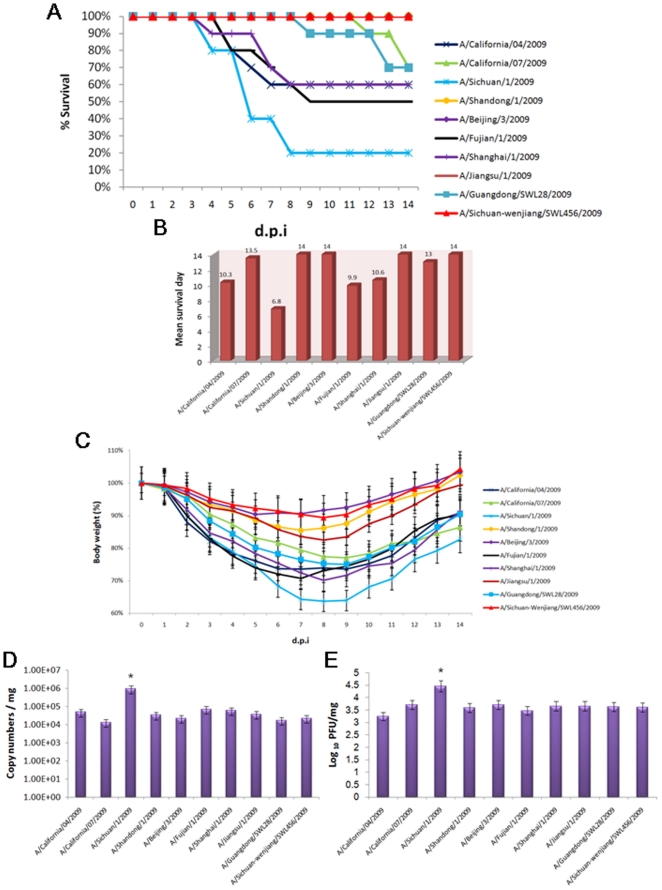
Virulence comparison of the ten 2009 pandemic A (H1N1) influenza viruses in BALB/c mice.Mice were anesthetized and inoculated intranasally with virus (n = 23 per group; 50 µl of 106 TCID50). Ten randomly selected mice were monitored daily for signs of disease and mortality, up to 14 d.p.i. for (A), (B), and (C) research, whereas ten of the remaining mice from each group were euthanized at 5 d.p.i. to obtain lung tissue biopsies for use in (D). The final three mice were also sacrificed at 5 d.p.i. and their lungs were collected for (E) detection. (A) Survival percentage of mice. (B) Mean survival days for each challenged group. (C) Body weight changes of infected mice. Mean body weight and SD were calculated as percentage of body weight and compared to those at 0 d.p.i. (D) Viral RNA loads in lung tissues at 5 d.p.i. Data are presented as mean viral loads per microgram ± SD. (E) Viral titers in lung tissues at 5 d.p.i. Data are presented as mean log10 PFU/mg. * P<0.05 compared to the values of other viruses (one-way ANOVA).